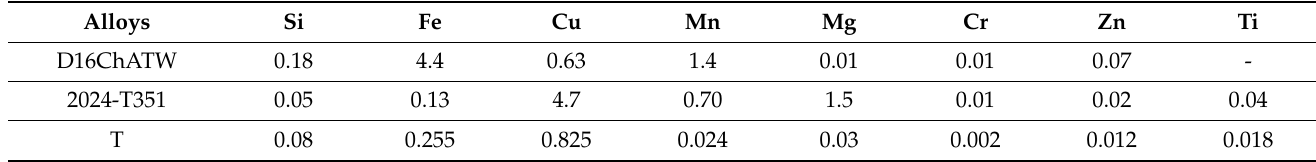
Table 1. Chemical composition of aluminum alloys, %.